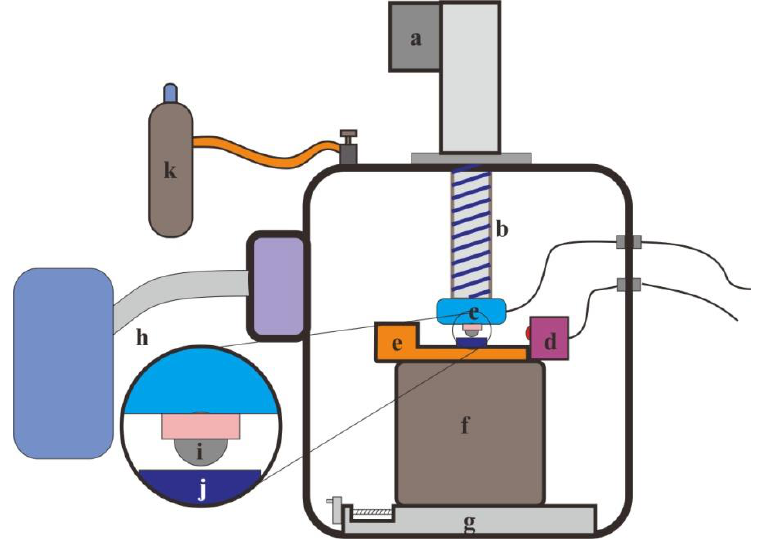
Figure 1. Fretting wear test rig: ( a ) Servo electric cylinder; ( b ) Lead screw; ( c ) Two-dimensional pressure sensor; ( d ) Laser copolymerization sensor; ( e ) Piezoelectric ceramics; ( f ) Base; ( g ) Screw module; ( h ) Molecular pump; ( i ) Counter-body; ( j ) Sample; ( k ) Vacuum chamber.